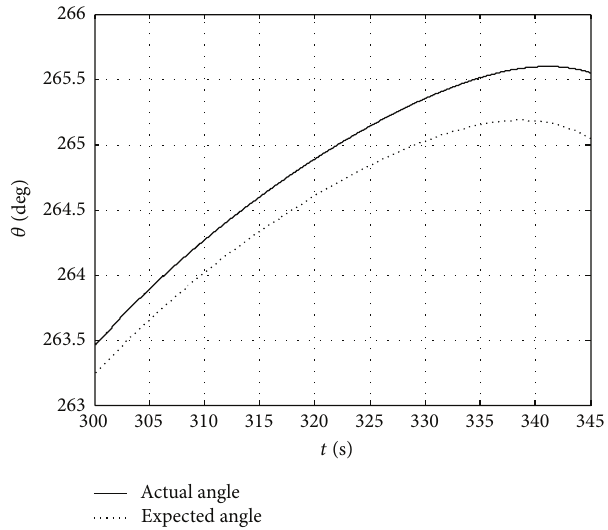
Figure 19: Simulation result of Mach